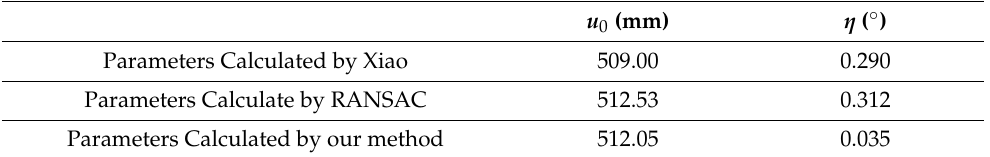
Table 5. Calibration parameters in the Ant data compared with the Xiao, RANSAC and our